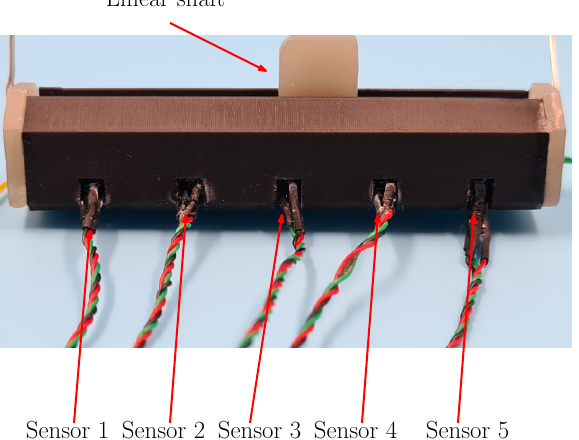
Figure 11. SMA linear actuator and the sensor array from magnetic actuators.